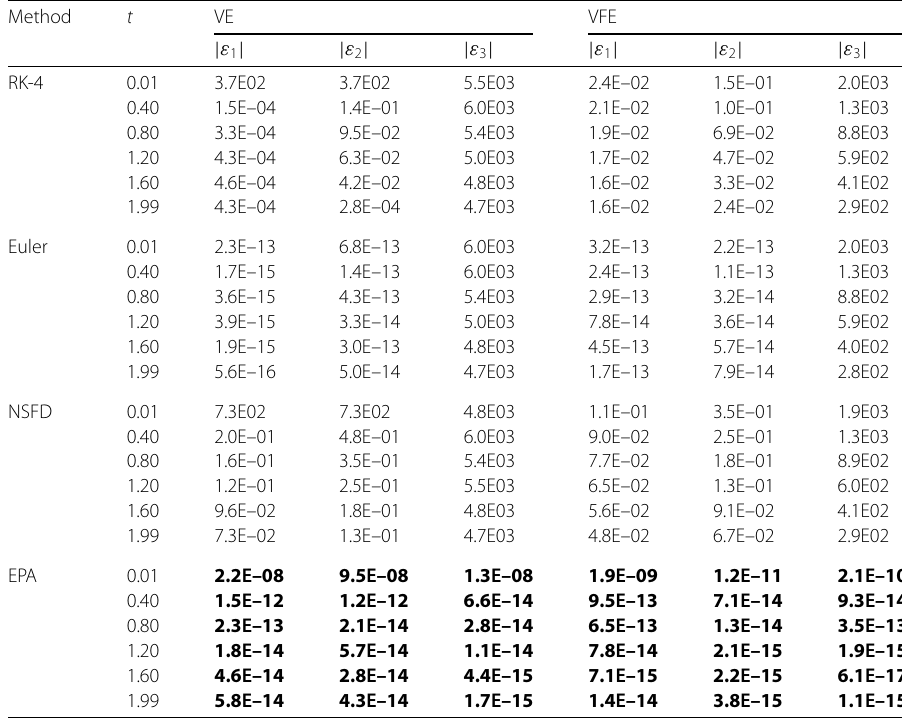
Table 3 Absolute residuals of numerical solutions for h = 0.01